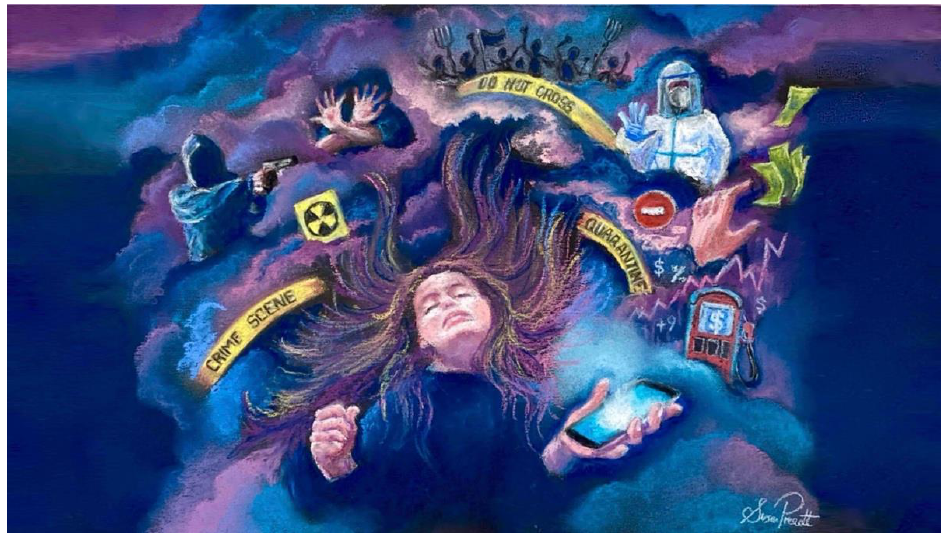
Figure 1. An era of unprecedented stress, anxiety, and uncertainty of a nature and scale we have never really seen before . We are facing multiple new large-scale threats to health, safety, security, to our social, economic, and political systems, and to our natural environments at all scales. This is being amplified by an exponential increase in the amount and immediacy of information propagated through electronic media, often negative with manipulative intent or ulterior motives aimed at dividing opinions through anger and fear. (Art created by author